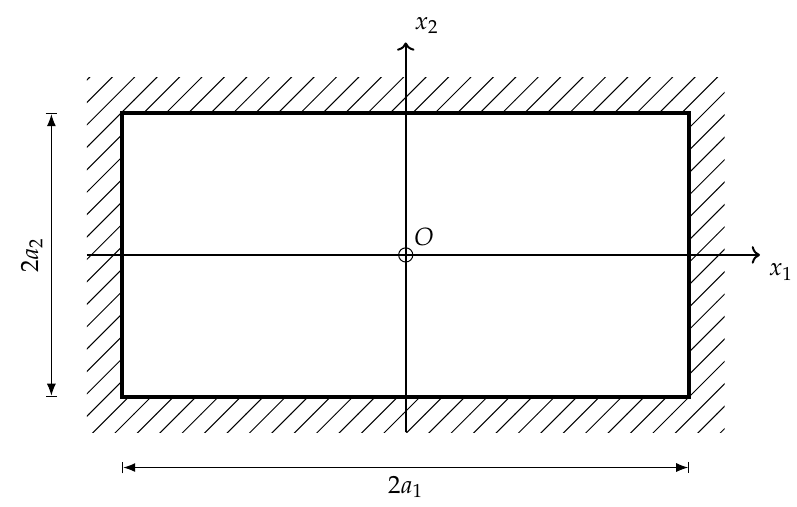
Figure 19. Rectangular plate clamped at the contour.